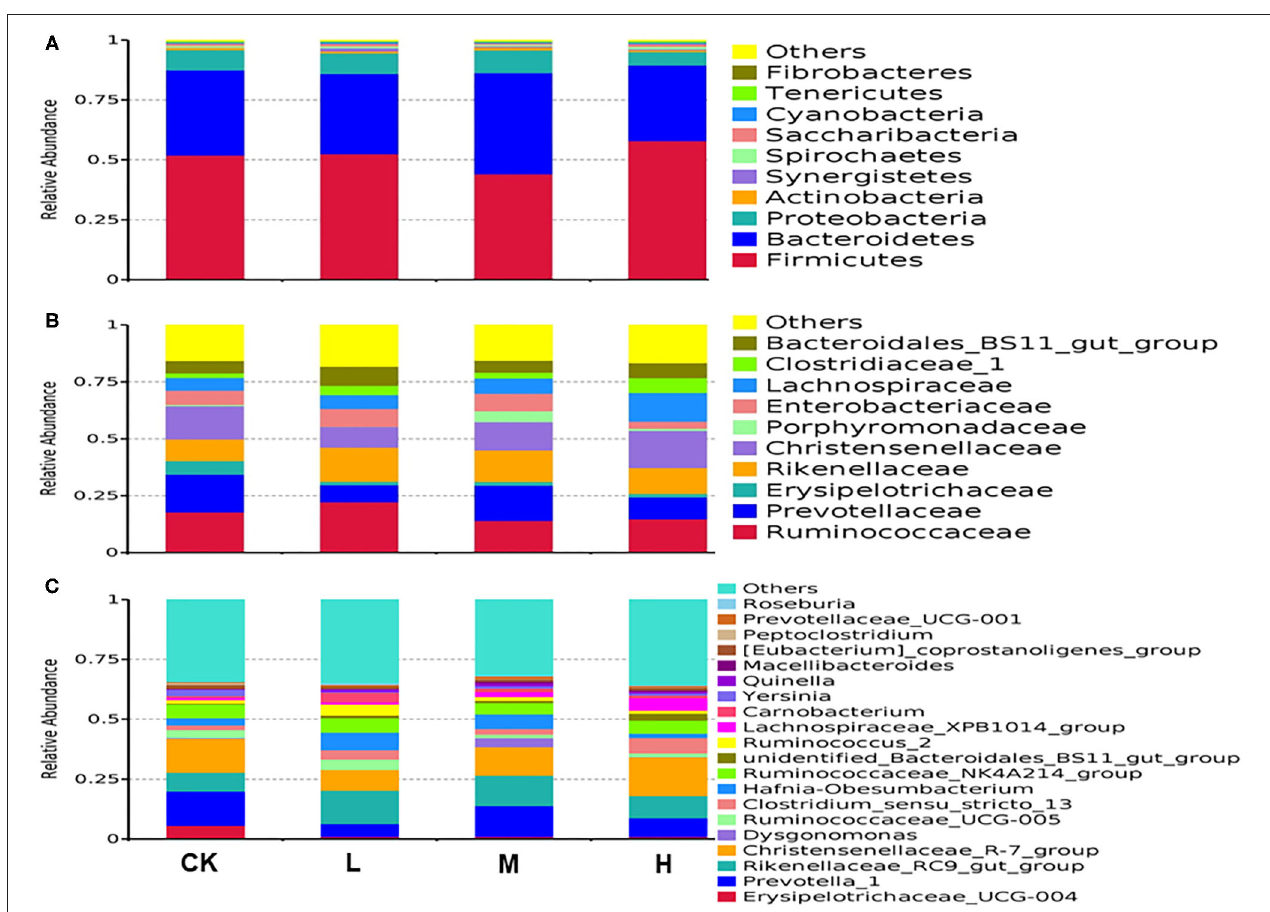
FIGURE 1 | Relative abundance of operational taxonomic units agglomerated of bacterial taxa averaged under phylum level for (A) , family level for (B) , and genera level for (C) at the four SeY doses (mg SeY/kg dry matter) (CK, 0; L, 0.09; M, 0.18; H, 0.36). The color-coded bar plot shows the average bacterial phylum, family, and genus distributions level of the nutritional diets sampled. CK, control; L, low Se, M, medium Se; H, high